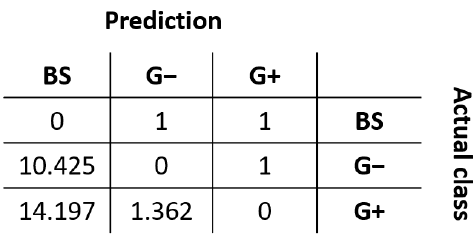
Figure 3. Cost matrix applied during the training process of the multi-classifier based on the Gram- staining types of the targets.